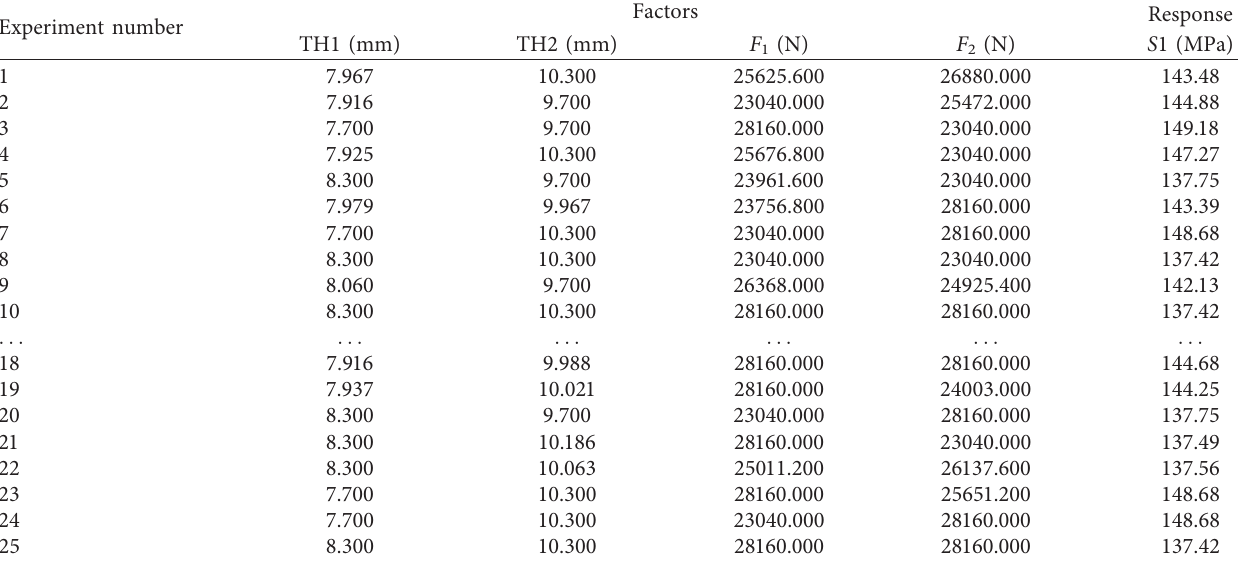
Table 3: Statistical characteristic of random